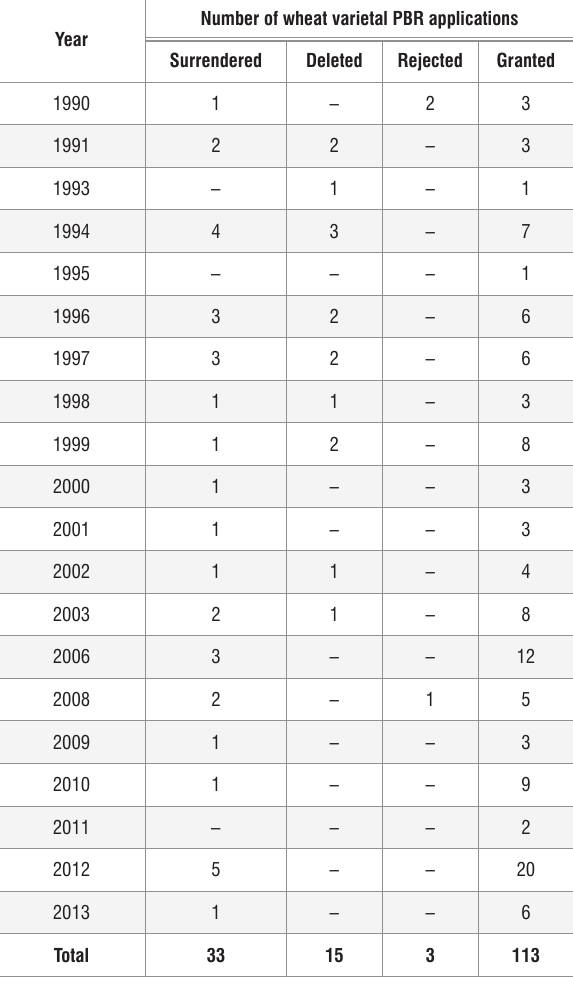
Changing disposition of plant breeders’ rights applications compiled from data in South African Plant Variety